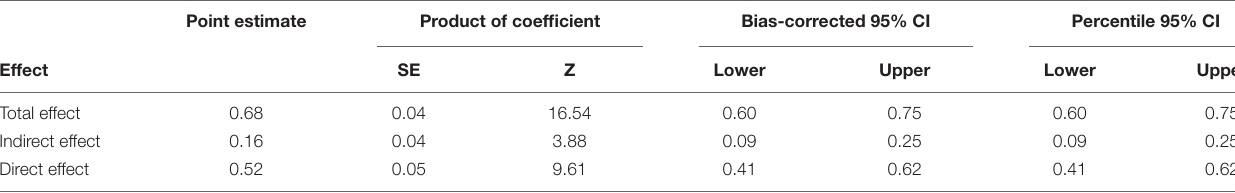
TABLE 5 | The mediating role of the CTBs bootstrap test